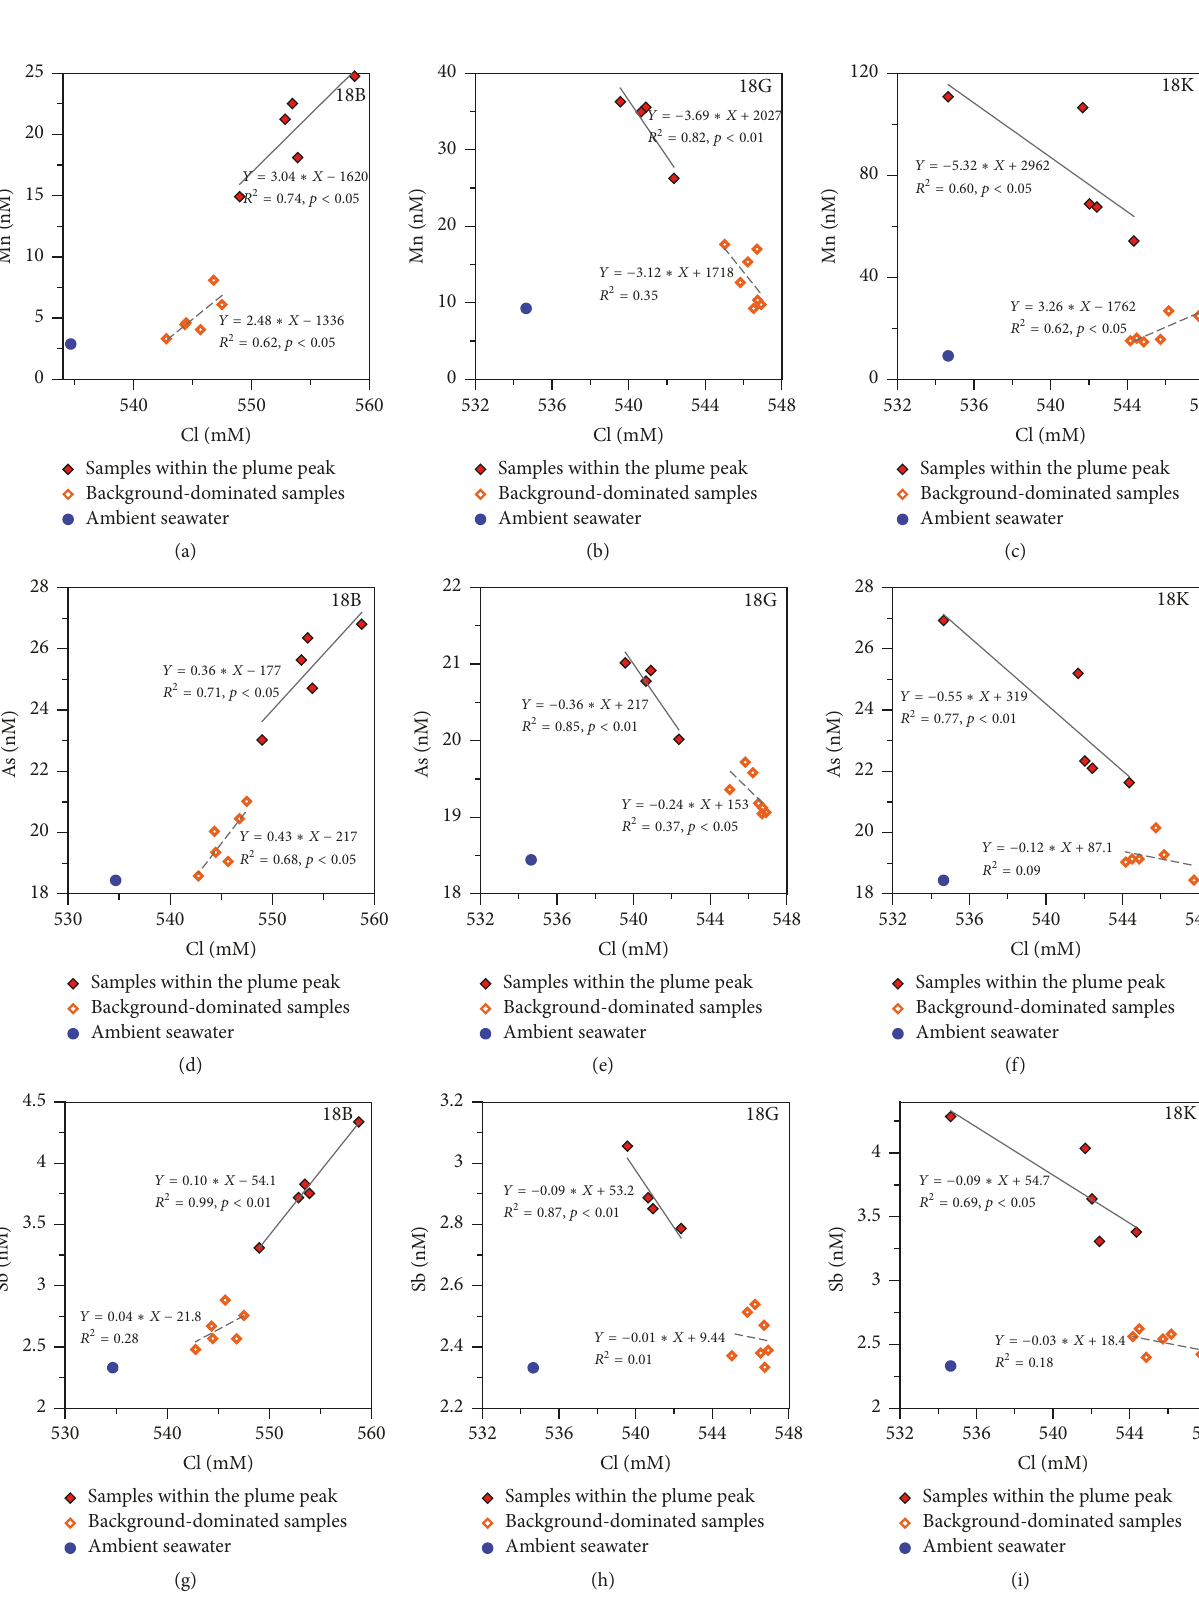
Figure 6: Correlations between Mn and Cl (a) at Station 18B, (b) at Station 18G, and (c) at Station 18K; correlations between As and Cl (d) at Station 18B, (e) at Station 18G, and (f) at Station 18K; and correlations between Sb and Cl (g) at Station 18B, (h) at Station 18G, and (i) at Station 18K in the plume in the eastern Manus